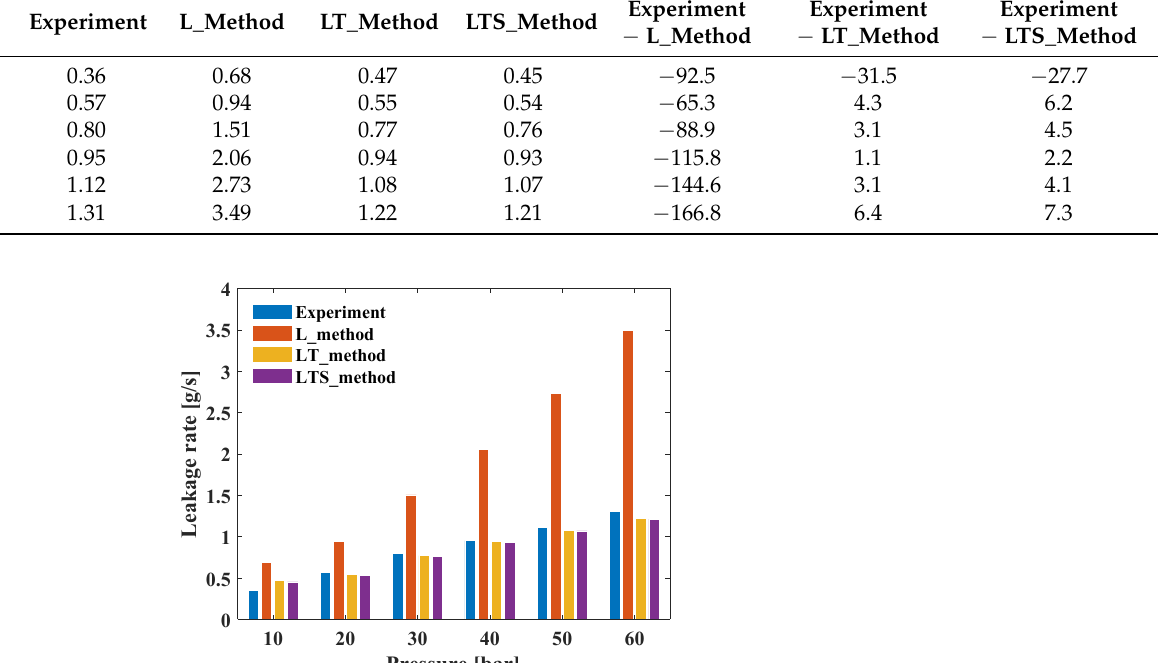
Figure 7. Measured and simulated leakage rate according to the change of the outer pressure.